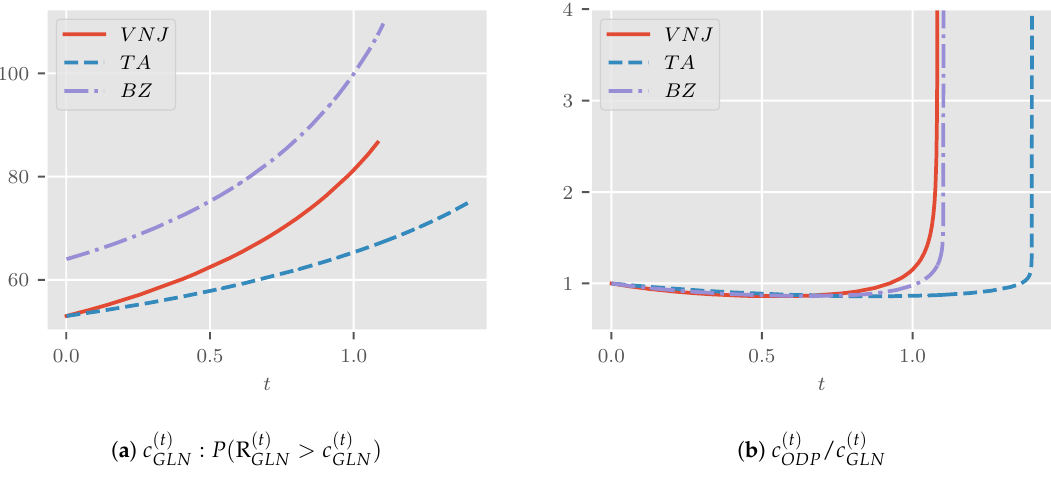
Figure 5. Critical values as t increases. ( a ) shows critical values of R ( t ) values of R ( t ) to R ( t ) ODP GLN